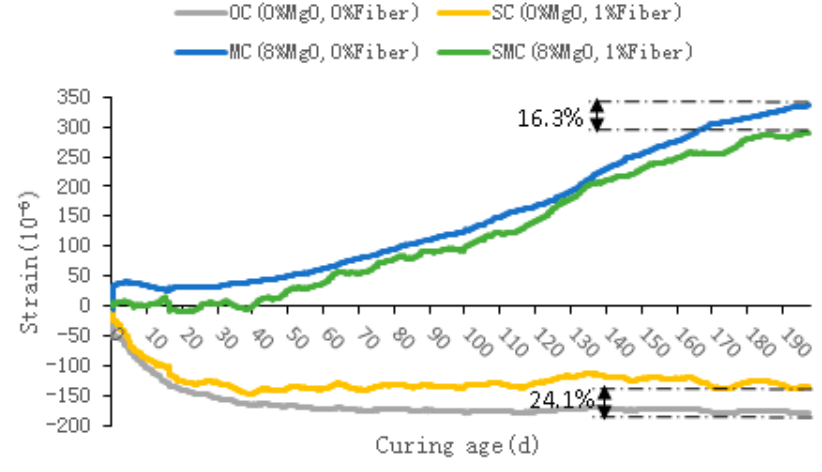
Figure 7. Self-volumetric deformation of concrete.